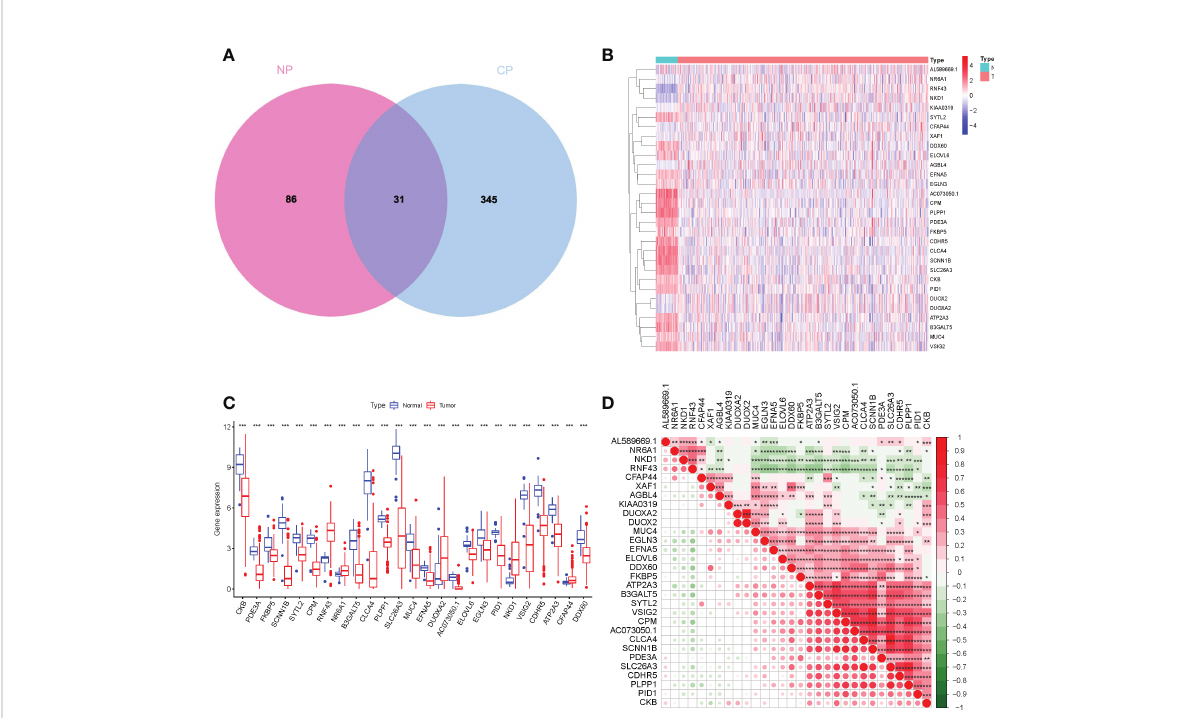
FIGURE 4 (A) Venn diagram to show ERDEGs between groups. (B) Heatmap of the expression of the 30 ERDEGs in tissues from patients with COAD and normal individuals of TCGA cohort. (C) A signi fi cant difference in the expression of ERDEGs in the colon tissues from patients with COAD and normal individuals. (D) Interaction analysis among the 30 ERDEGs. *P< 0.05, **P< 0.01, ***P<